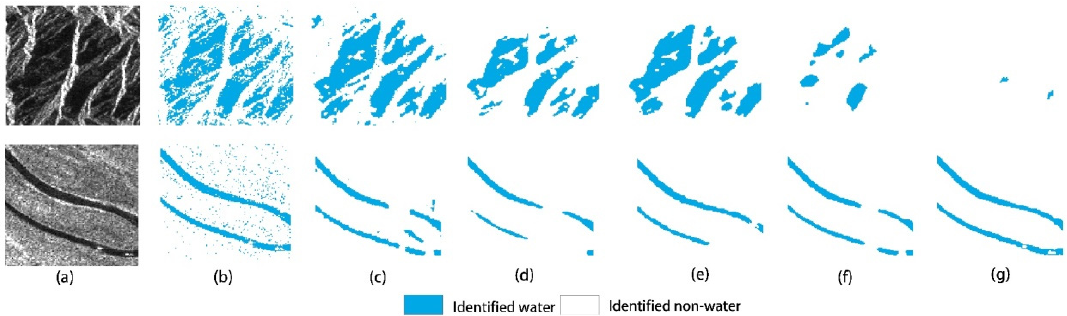
Figure 17. Results of mountain shadow and narrow rivers. ( a – g ) Raw images, TS, SegNet, Deeplabv3+, UNet, Attention-UNet, and Attention-UNet3+, respectively.